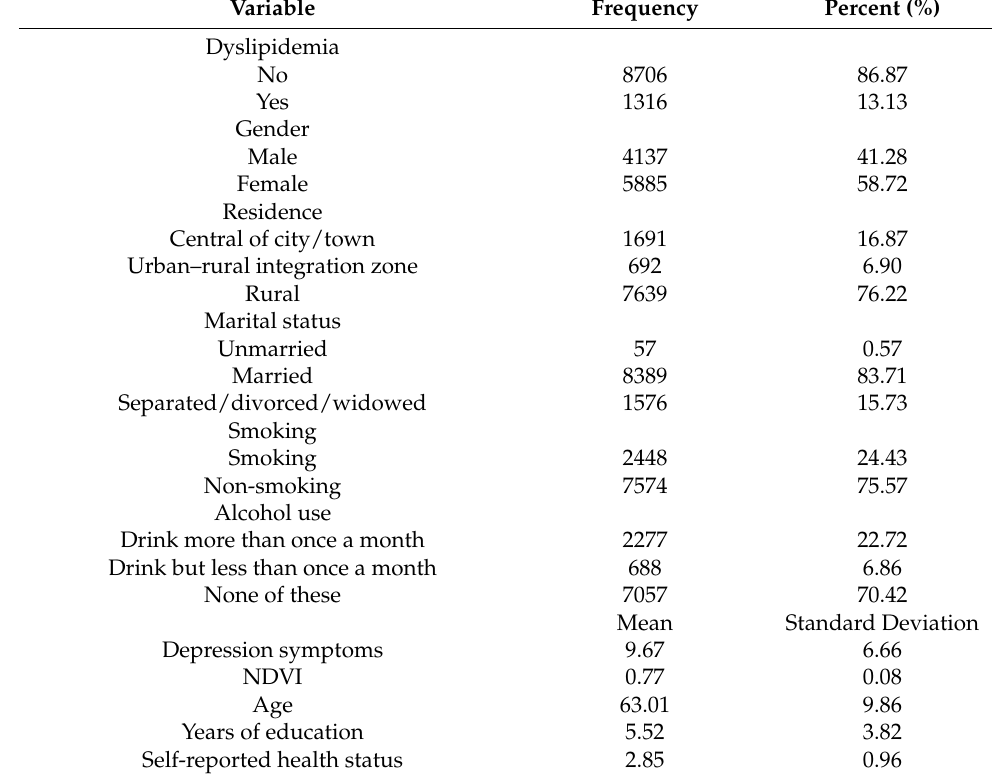
Table 1. Descriptive analysis (N =